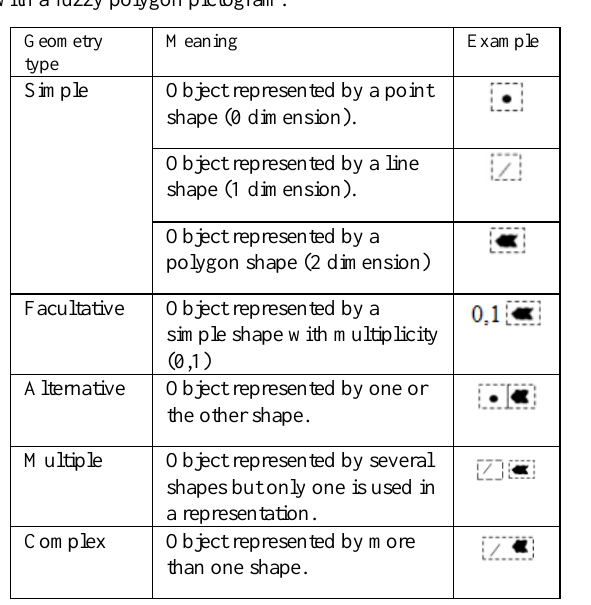
Table 1: F-Perceptory types of spatial geometries Based on primitive shapes, the specification of F-Perceptory